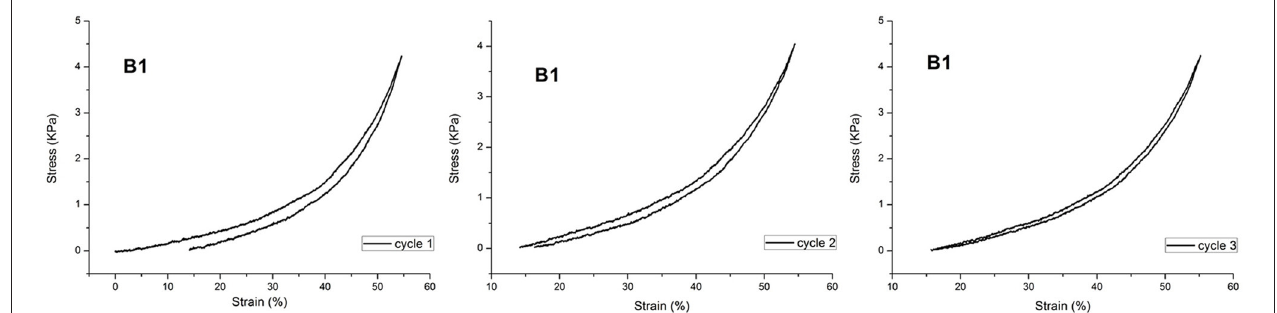
FIGURE 4 | Cyclic compression curves for B 1